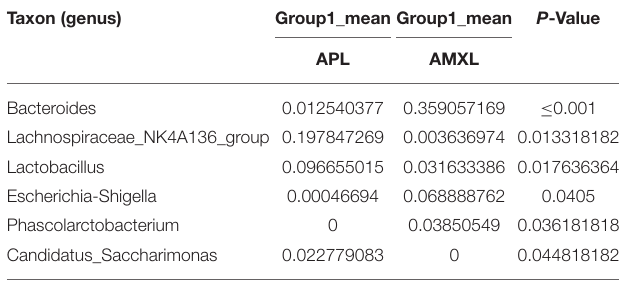
TABLE 4 | Based on Metastats analysis for flora differences between APM and Con groups under the genus.